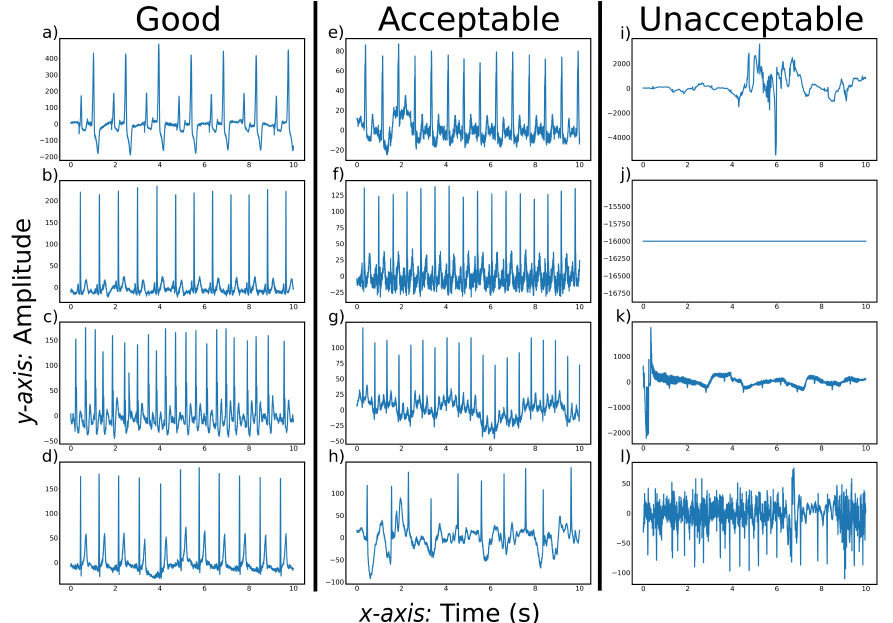
Figure 5. Typical examples of CinC11 [4] signals at three quality levels. ( a – d ) show ECG recordings with regular beats of good quality. ( e – h ) show ECG recordings of acceptable quality that can become good quality after preprocessing. ( i – l ) show ECG recordings of unacceptable